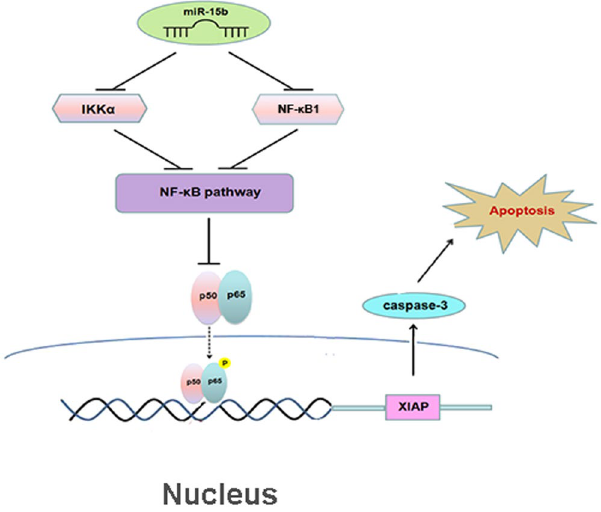
Figure 6. The schematic diagram of possible molecular mechanism of miR-15b-5p-induced apoptosis in CRC